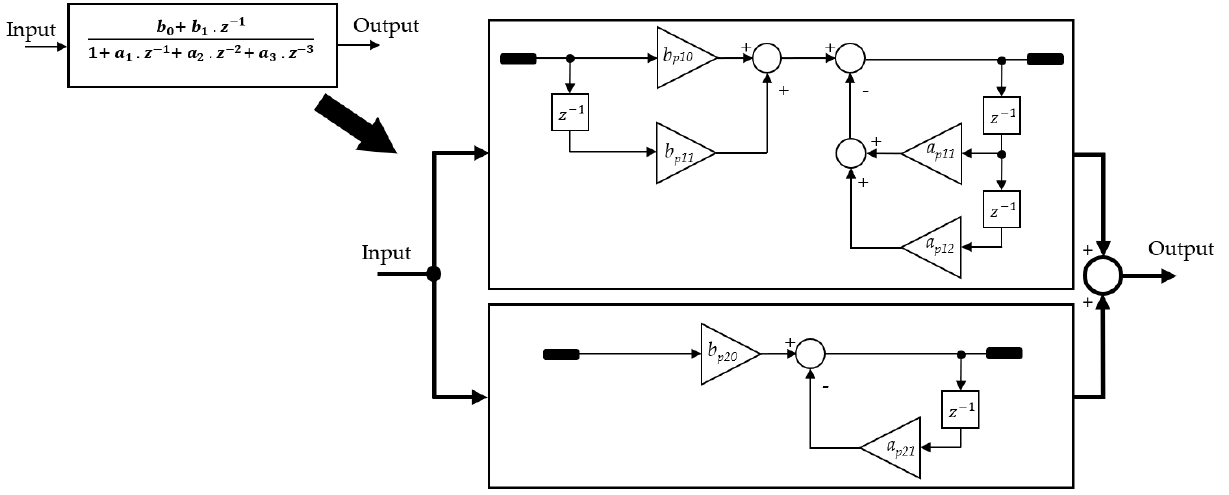
Figure 4. Parallel form of the implemented transfer functions.